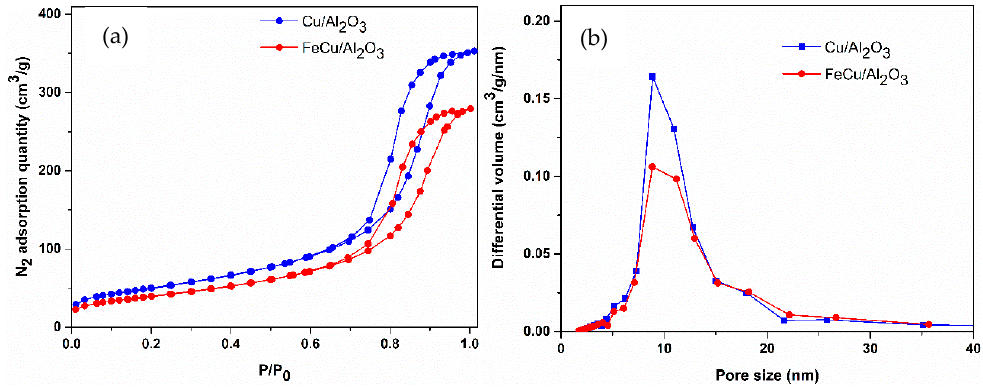
Figure 1. ( a ) N 2 adsorption/desorption isotherms and ( b ) pore size distribution of all of the catalysts (calculated by the BJH method).